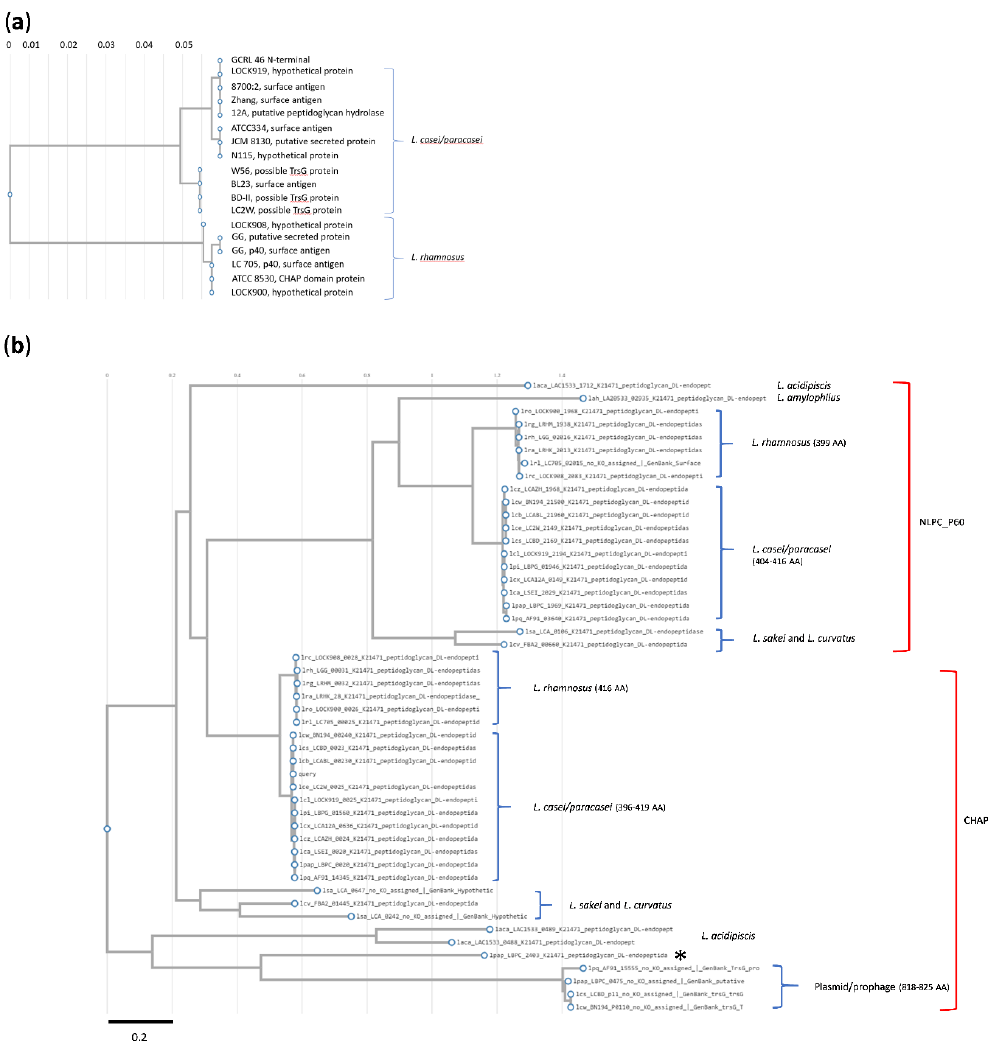
Figure 3. Mid-point rooted phylograms constructed using KEGG TREE for Lactobacillus peptidoglycan D , L -endopeptidases. Panel ( a ): the query sequence in BLASTp searches was the 20 amino-acid N-terminal sequence for the acid up-regulated protein from L. paracasei GCRL 46. Panel ( b ): the query sequence was the protein identified from searching the genome of L. casei GCRL 163 using the N-terminal sequence; other genera in this list (three examples, Enterococcus and Vagococcus species) were excluded. The red brackets indicate the protein groups sharing common domains, CHAP or NLPC_P60 amidase. The size ranges of proteins (number of amino acids, AA) seen in closely-related clades are shown in parentheses; * notes a protein of 325 AA in L. paracasei subsp. paracasei JCM 8130 (LBPC_2403) that is likely